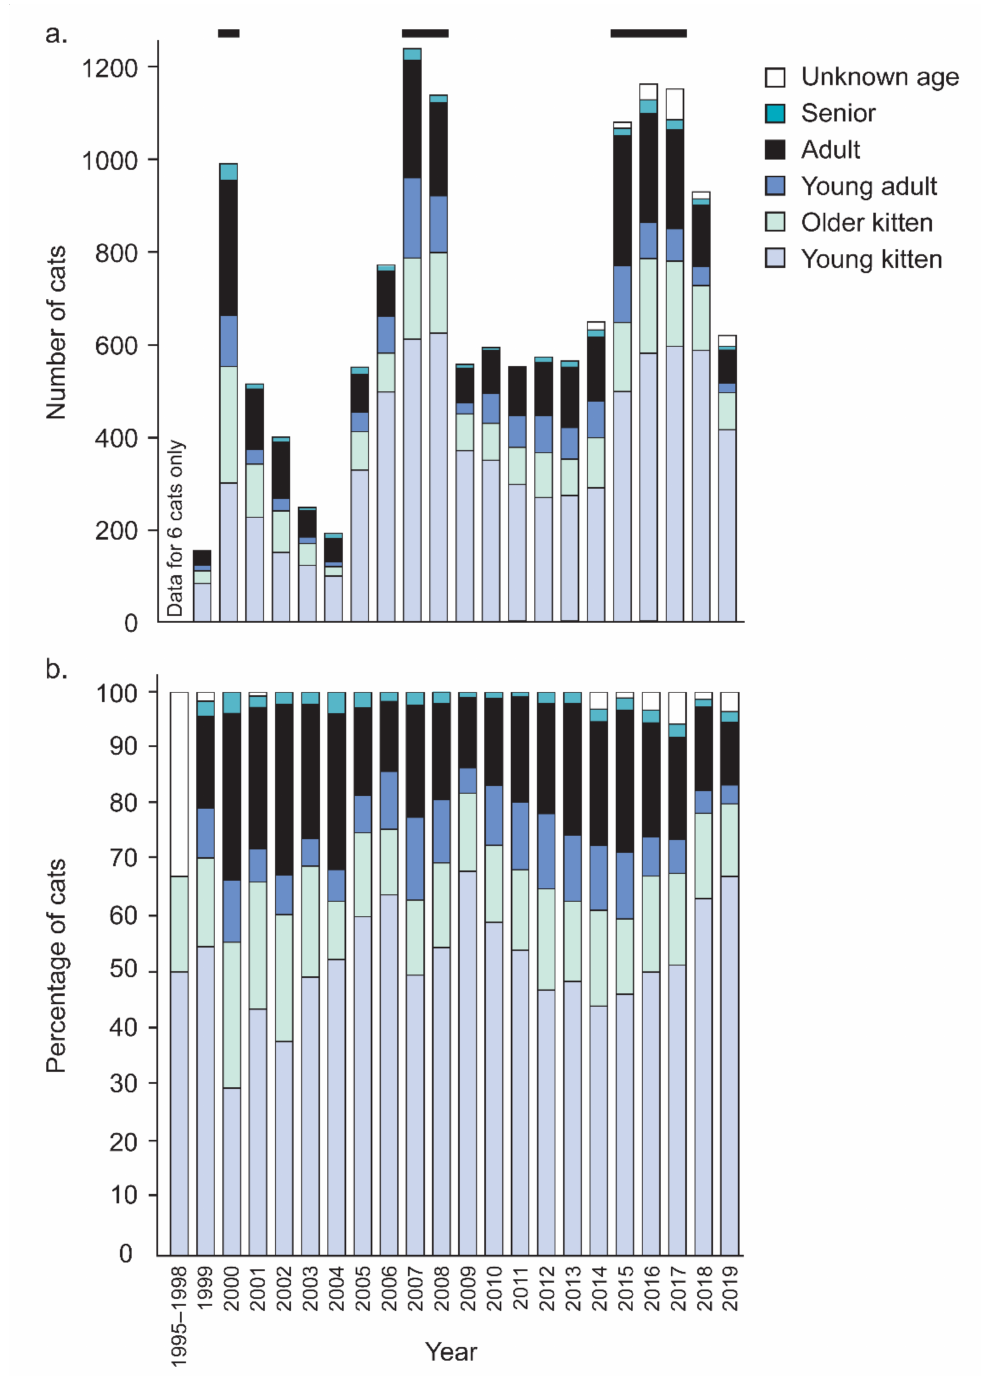
Figure 2. The age of cats processed for trap–assess–resolve (TAR) through Lonely Miaow, Auckland, New Zealand, between July 1995 and December 2019, showing the breakdown by year. Rectangles at the top highlight 6 years where efforts exceeded ~1000 cats per annum. The exact numbers are shown in ( a ) and the percentages in ( b